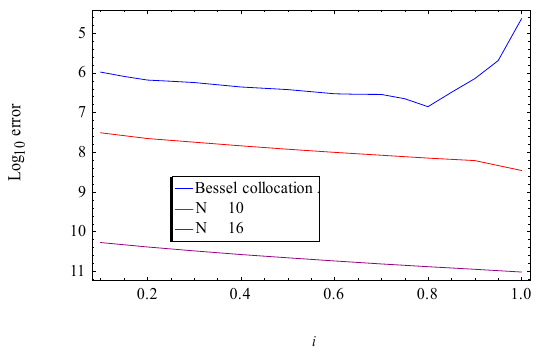
ff erent N values.